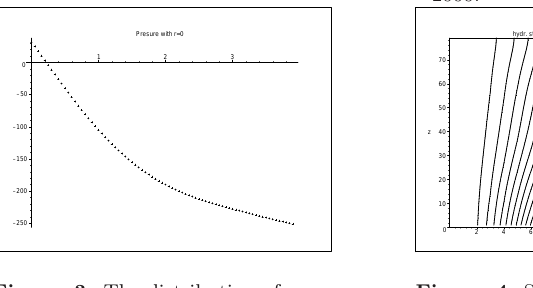
Figure 3. The distribution of pres- sure on an axis with the reduced in- put, Re = 10 .